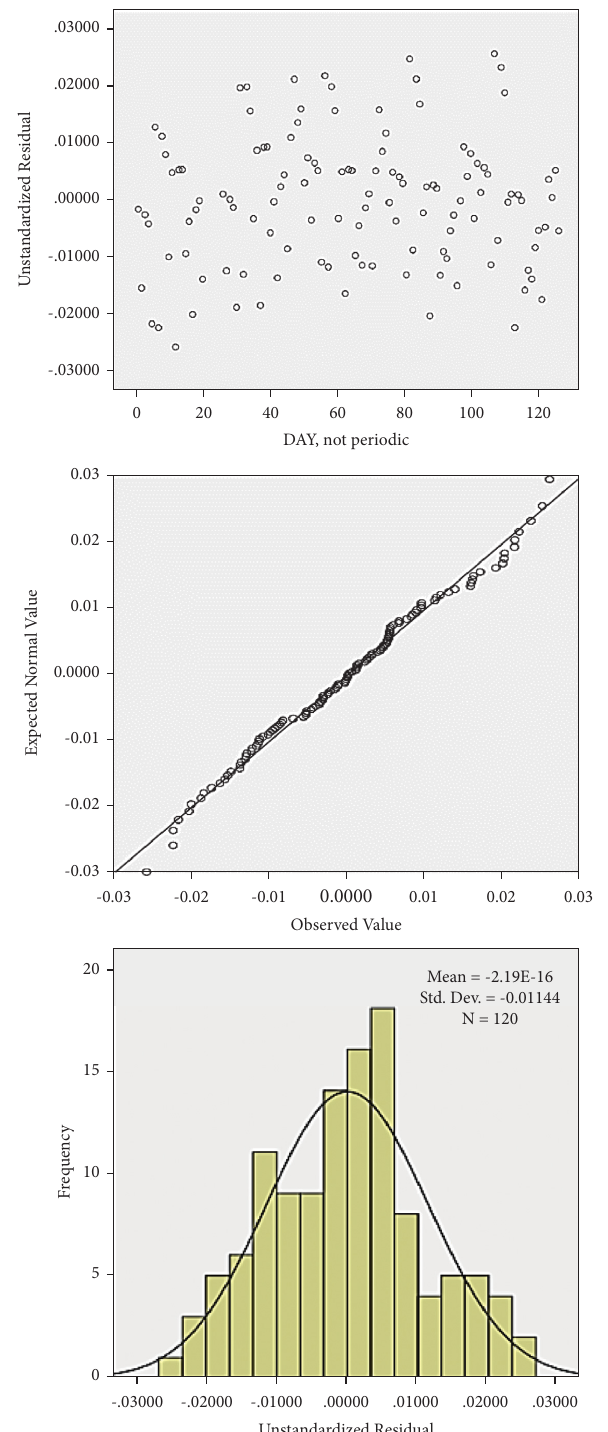
Figure 15: Histogram, quadratic diagram, and variance diagram of lateral acceleration model residues.